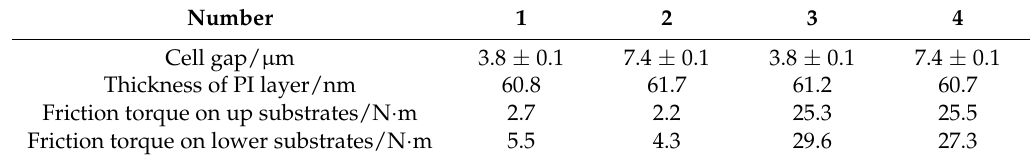
Table 2. Parallel-aligned nematic (PAN) cells with different cell gaps and friction torques.